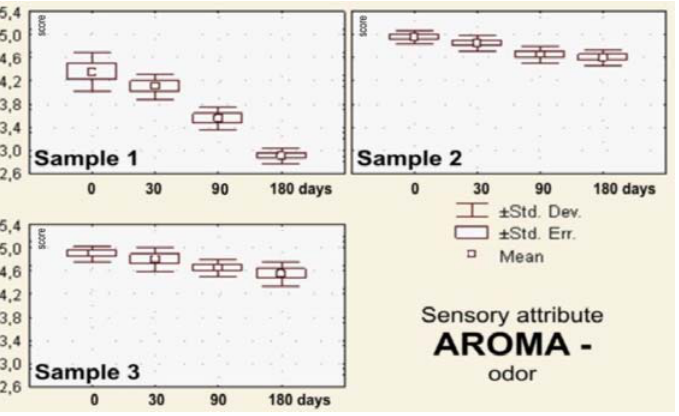
Figure 5. Box plots for sensory attribute aroma— odor of the filled pralines (labels as in the Figure 2), during 180 days of storage.